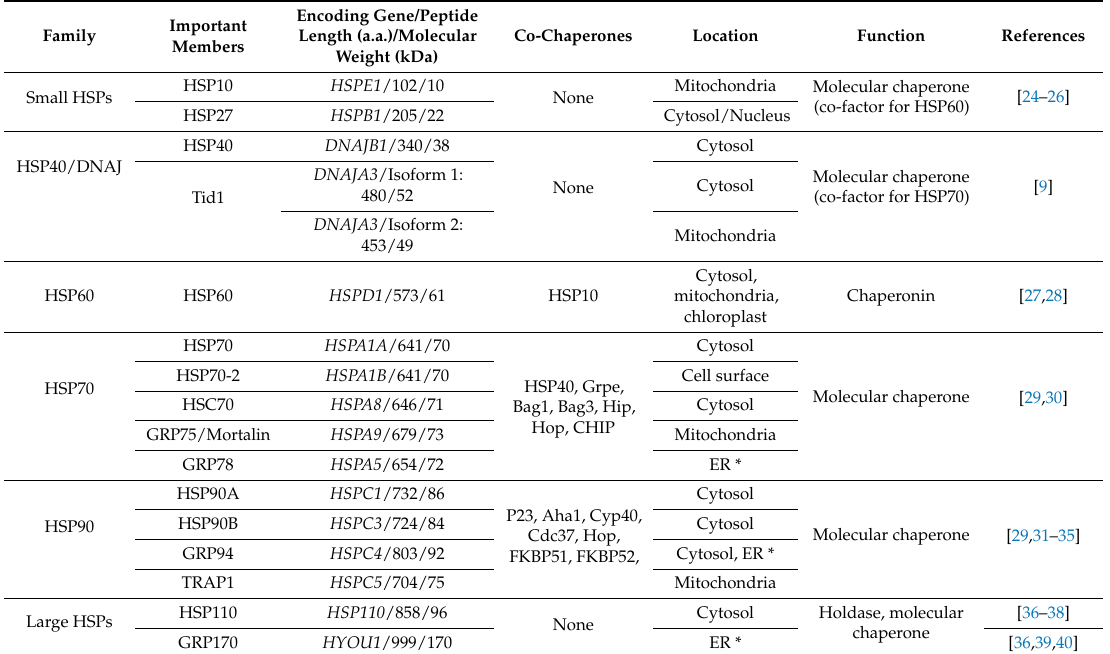
Table 1. Brief summary of heat shock protein (HSP) families, important members and their cellular location and